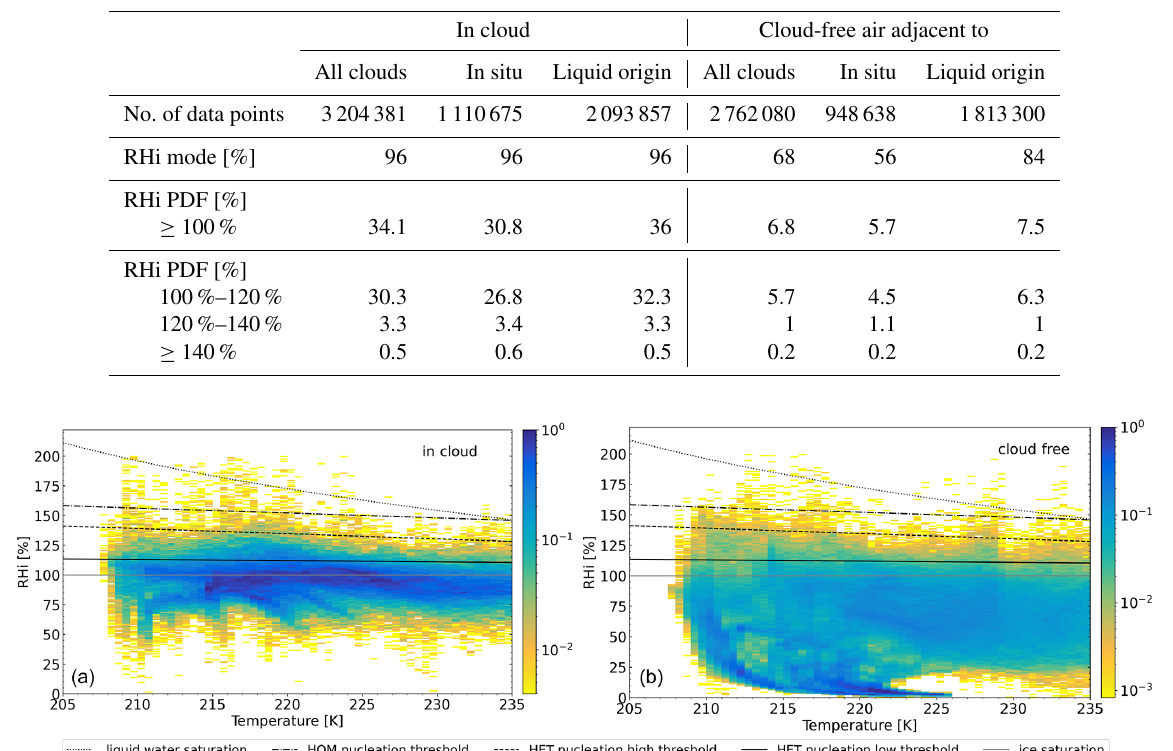
Figure 2. Probability densities of the relative humidity over ice (RHi) with respect to ambient temperature. (a) Calculated for the in-cloud data points. (b) Calculated for the cloud-free data points. The bin sizes are 0.5K and 1% RHi. The grey line depicts the ice saturation threshold at RHi = 100%. The solid black line is the low threshold for heterogeneous nucleation (HET). The ice-nucleating particle (INP) for this threshold corresponds to mineral dust, which is efficient as an initiator of ice formation. The dashed line represents the high threshold for HET nucleation. Here the INP corresponds to coated soot, which is not activated as easily as mineral dust. The dash-dotted line indicates the threshold at which homogeneous nucleation (HOM) can take place. During HOM, ice crystals form without the need of INPs. The dotted line is the supercooled liquid water saturation